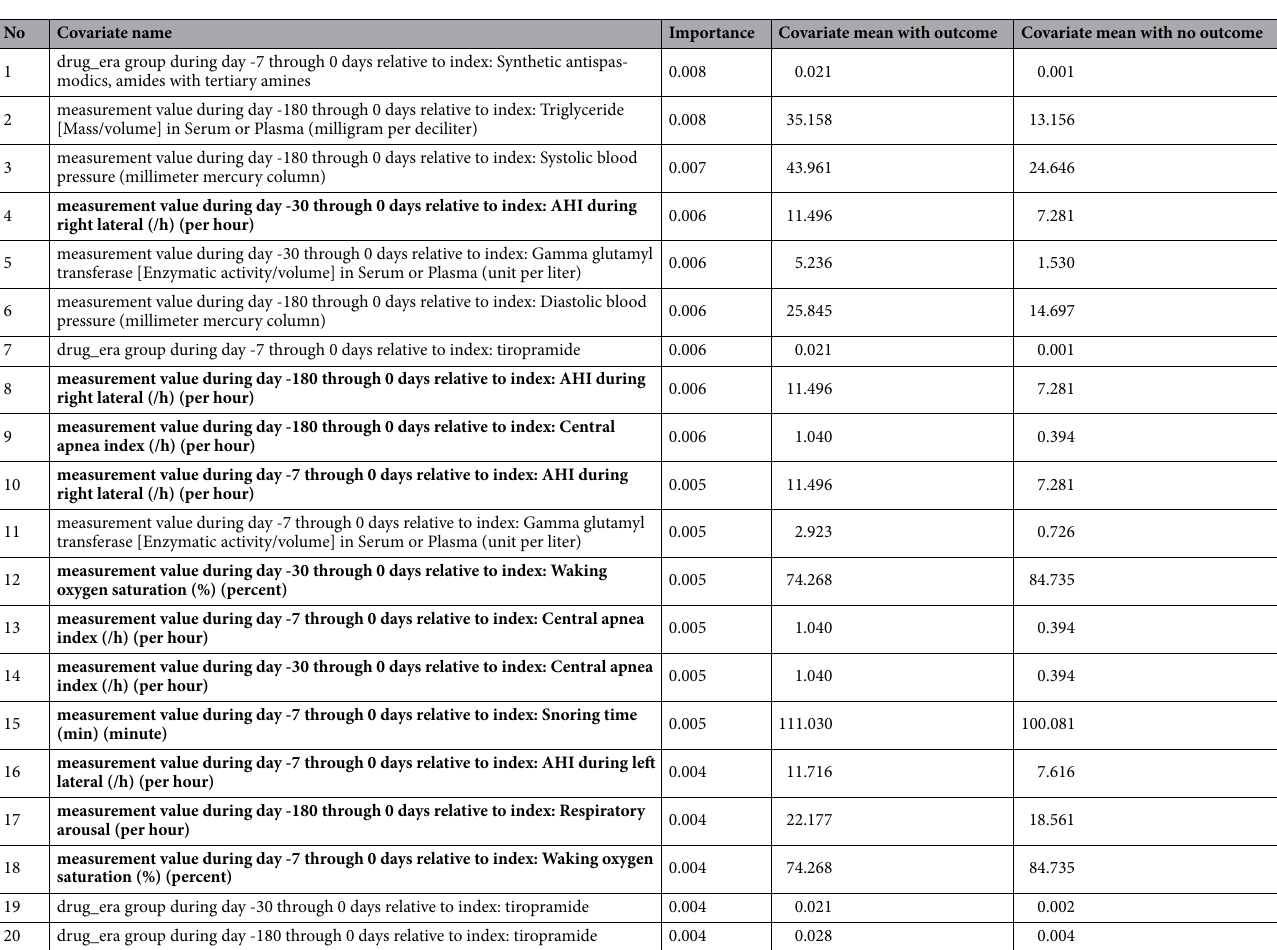
Table 4. Top 20 predictors selected from random forest model. The polysomnography parameters are indicated in